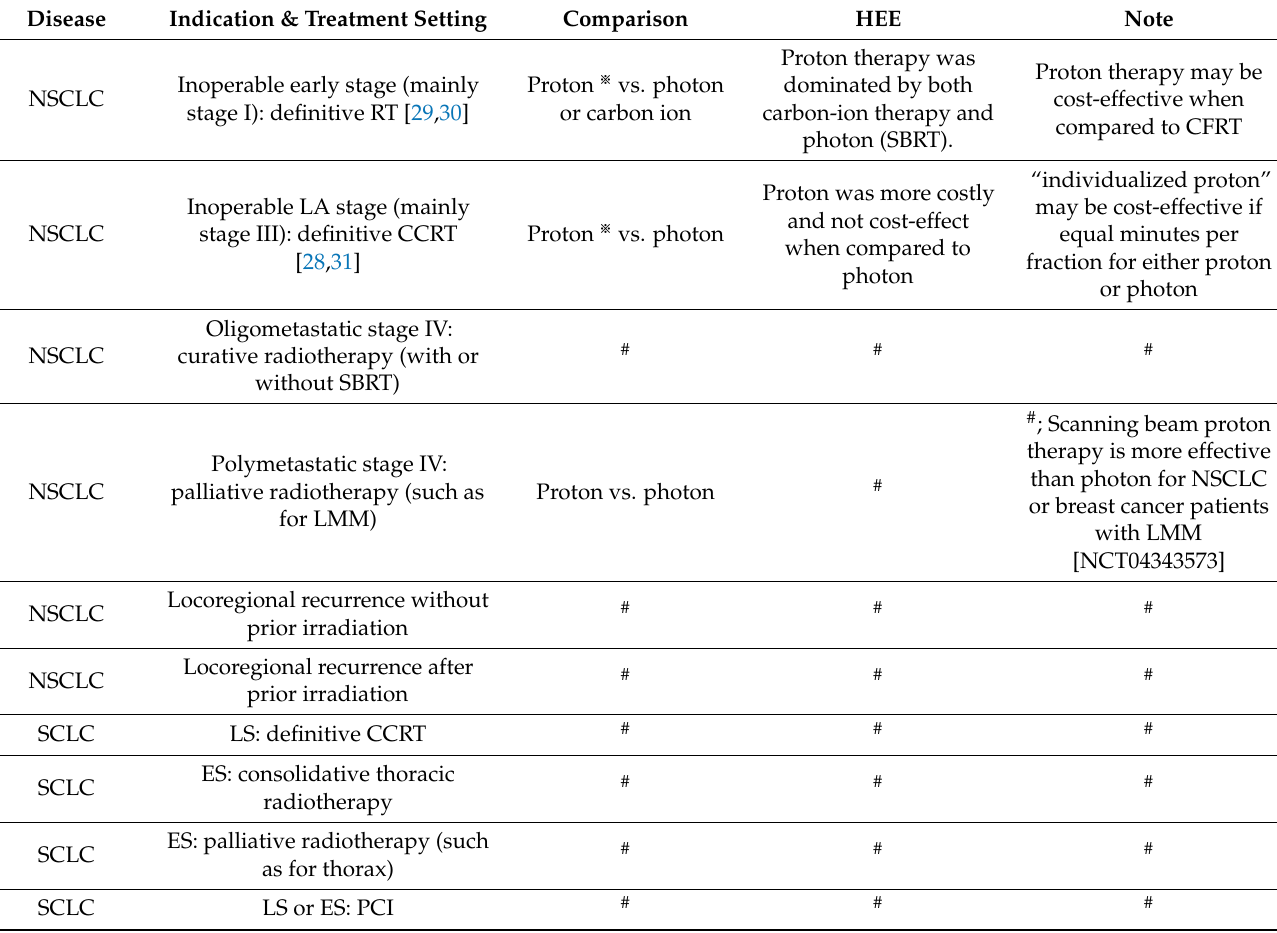
Table 2. Summary table by common lung cancer radiotherapy indications [modified from